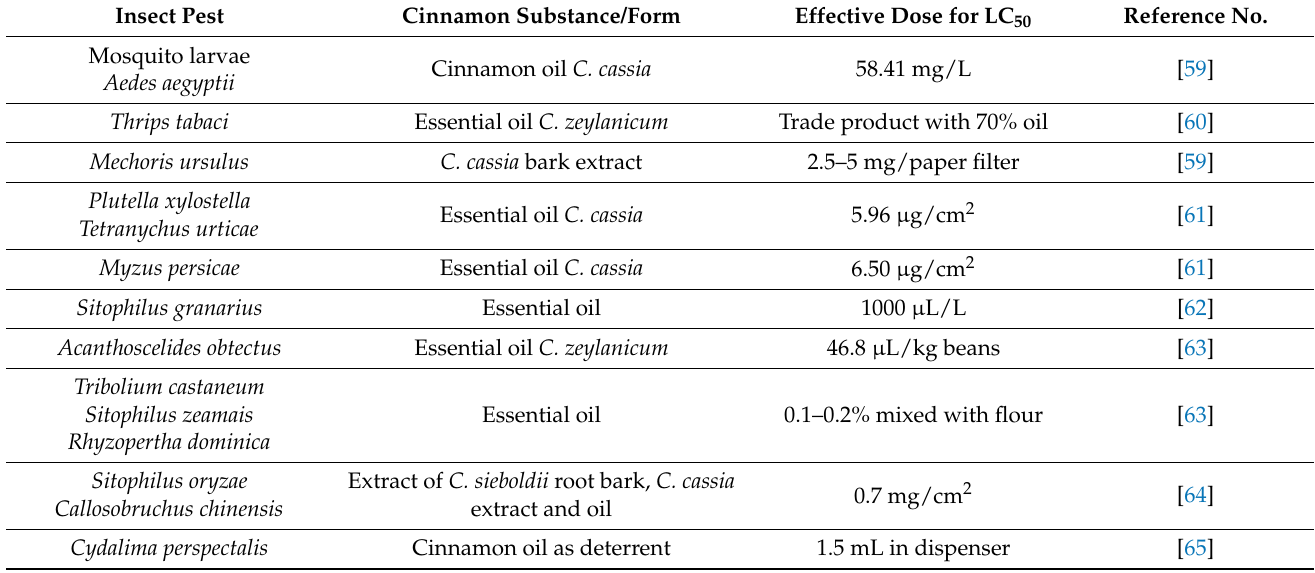
Table 3. Insecticidal activity of